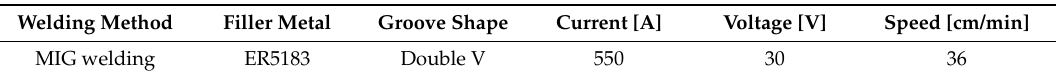
Table 2. Welding conditions for the Al 5083-O weldment.